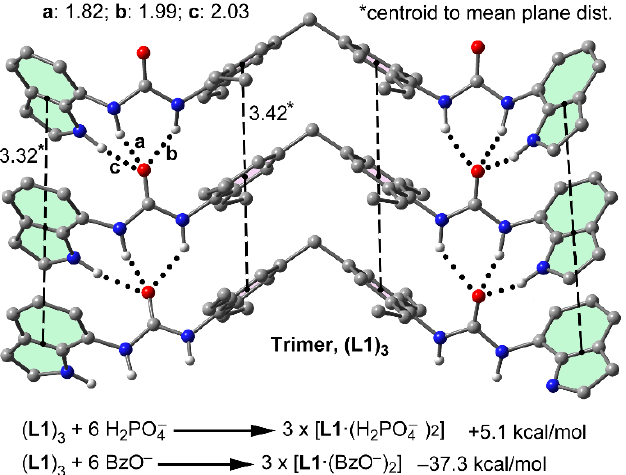
Figure 5. Optimised geometry (PB86-D3/def2-TZVP in DMSO) of the trimer of L1 (Distances in Å for H-bonds labelled a, b and c, H atoms omitted for clarity apart from those belonging to the NHs) and calculated free energy changes associated with the transformation of the trimers into monomers interacting with 2 equivalents of BzO − and H 2 PO 4 − .